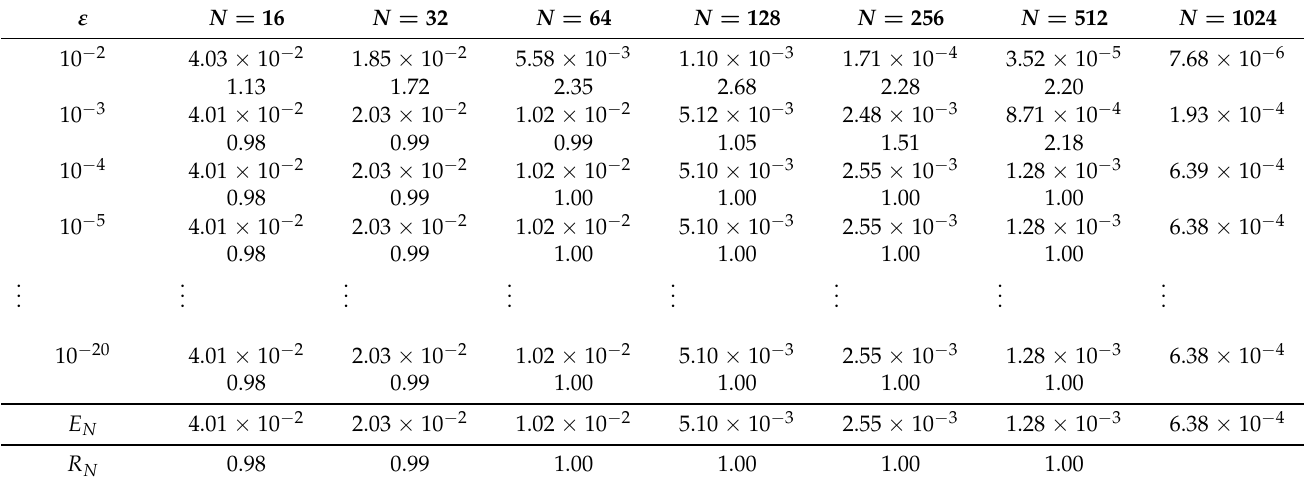
Table 2. Results for Example 2: maximum errors and convergence rate for FOFDM.